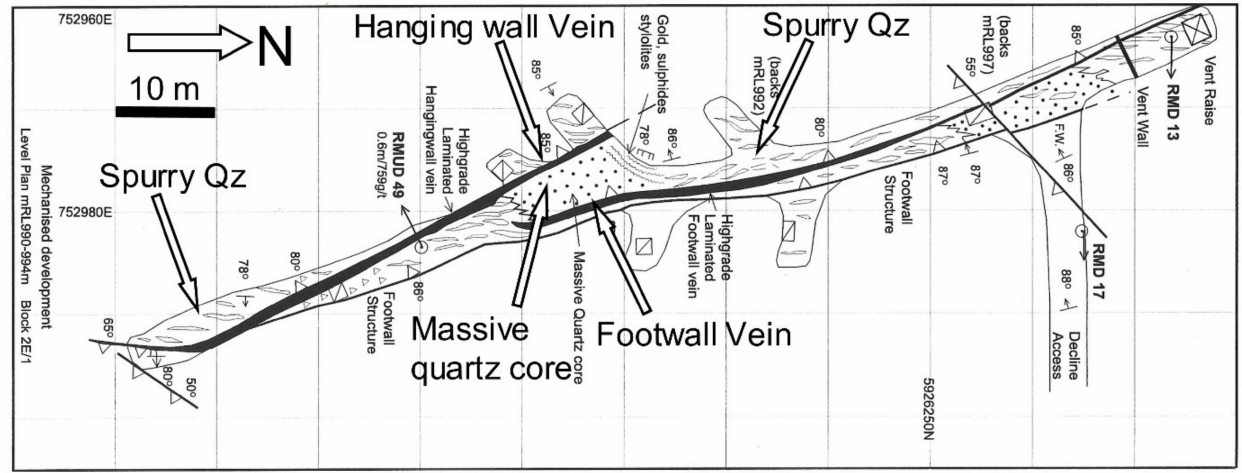
Figure 4. Geological plan of the 992 m level, Block 2E/1 in the NOT showing the laminated hanging- and foot-wall veins (black) and central-barren massive-quartz core. Grade of development 20 g/t Au over 60 m strike length (after